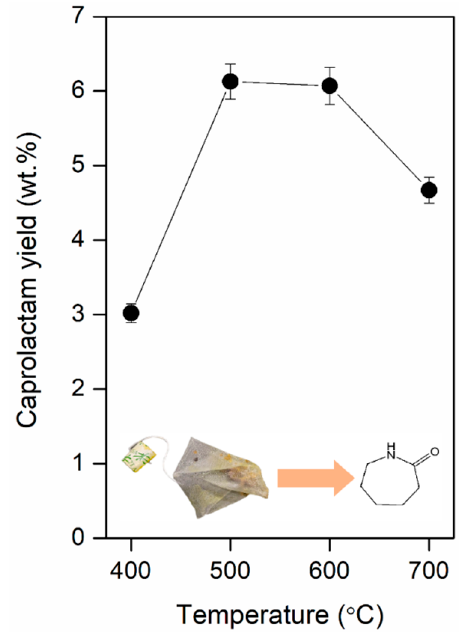
Figure 5. Yield of caprolactam (on the basis of weight of the feedstock) obtained by the pyrolysis of the TBW as a function of the pyrolysis temperature. Mean values of replicates ( n = 3) are reported with the standard deviations as error bars.